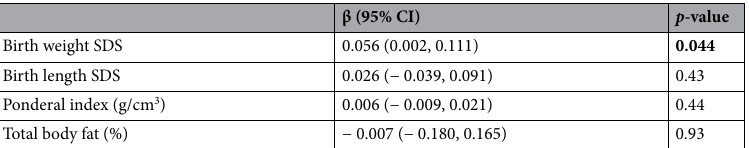
Table 1. Neonatal anthropometry and body composition measured in the offspring (n = 77) in association with maternal body mass index (BMI) in mid-gestation. Data are β coefficients and 95% CI derived from general linear models, including maternal gestational weight gain, and adjusted for child’s sex, gestational age at birth, and trial group allocation; mid-parental height SDS was also added as a covariate for length SDS. Body composition (total body fat) was measured at 2 to 3 weeks postpartum. CI, confidence interval; SDS, standard deviation score. p -values for statistically significant associations (at p < 0.05) are shown in